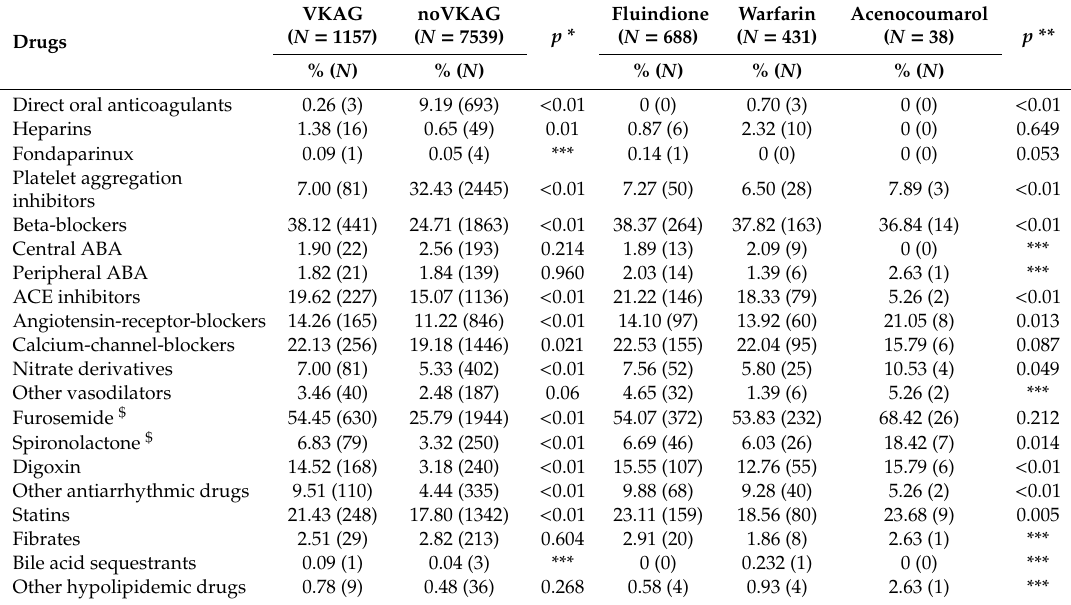
Table 3. Comparison of cardiovascular medications in subjects prescribed or not prescribed vitamin K antagonists on the one hand, and the three subgroups of vitamin K antagonists on the other hand.